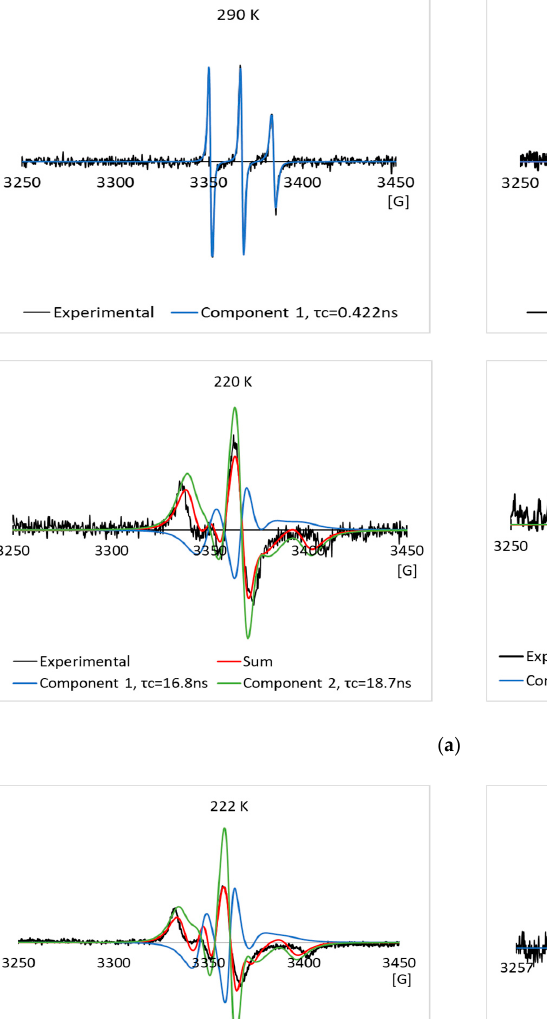
Figure 6. Typical experimental EPR spectra, and their simulated EPR spectra of the 2.0 mg/mL spin labeled A17C in the 5% glycerol solution in the freezing process ( a ), and melting process ( b ), respectively.